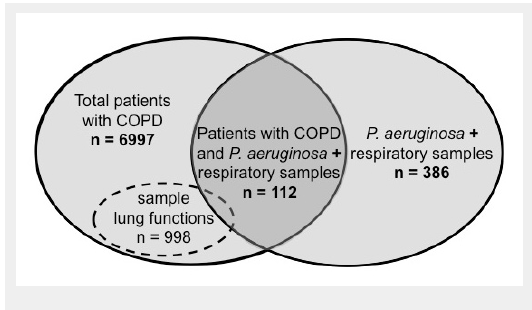
Overview of study population, sample lung function sub-population, and respiratory samples included in the analyses during the study period from 1 January 2004 to 31 December 2008. Total patients with COPD, patients either hospitalised or seen as outpatients between 1 January 2004 and 31 December 2008 at Bern University Hospital who had COPD as primary diagnosis or co-morbidity; lung functions, representative sample population of COPD patients who underwent lung function testing in the respiratory medicine department during the study period; P. aeruginosa + respiratory samples, isolates (sputum, induced sputum, tracheo-bronchial aspirate, broncho-alveolar lavage) from which P. aeruginosa was cultured.